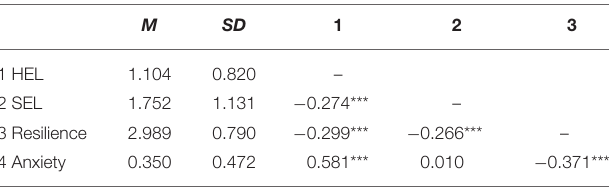
TABLE 1 | Descriptive statistics and correlation matrix of all variables.